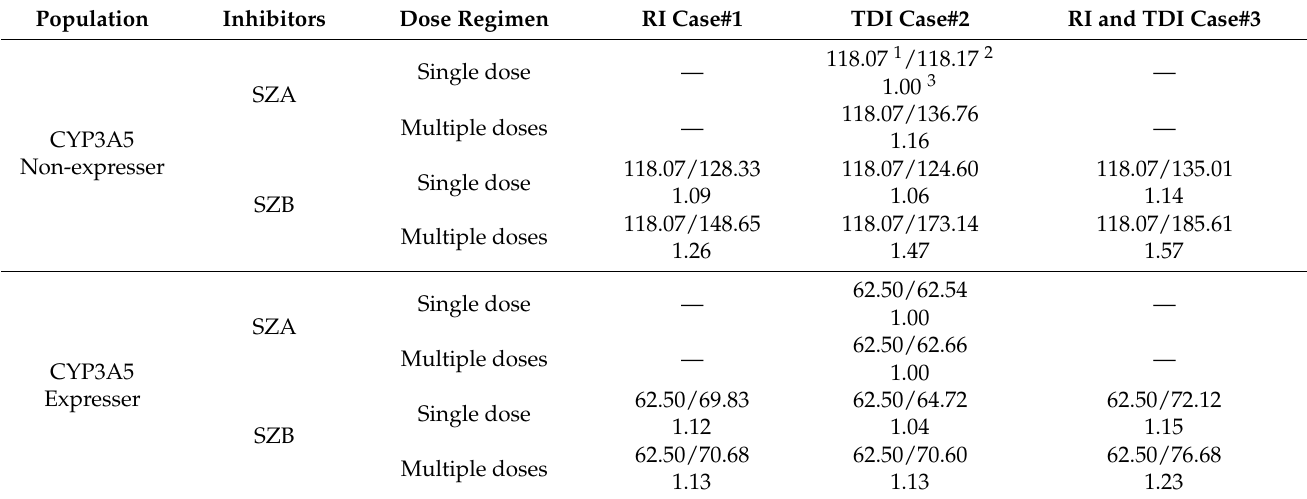
Figure 8. Change in tacrolimus exposure after a single dose of 10.8 mg SZB in CYP3A5 expressers ( A ) and CYP3A5 non-expressers ( B ); and after multiple doses of SZB (5.4 mg b.i.d. for 13.5 days) in CYP3A5 expressers ( C ) and CYP3A5 non-expressers ( D ). Table 2. Alterations in tacrolimus exposure after a single dose or multiple doses of SZA and SZB in CYP3A5 expressers and